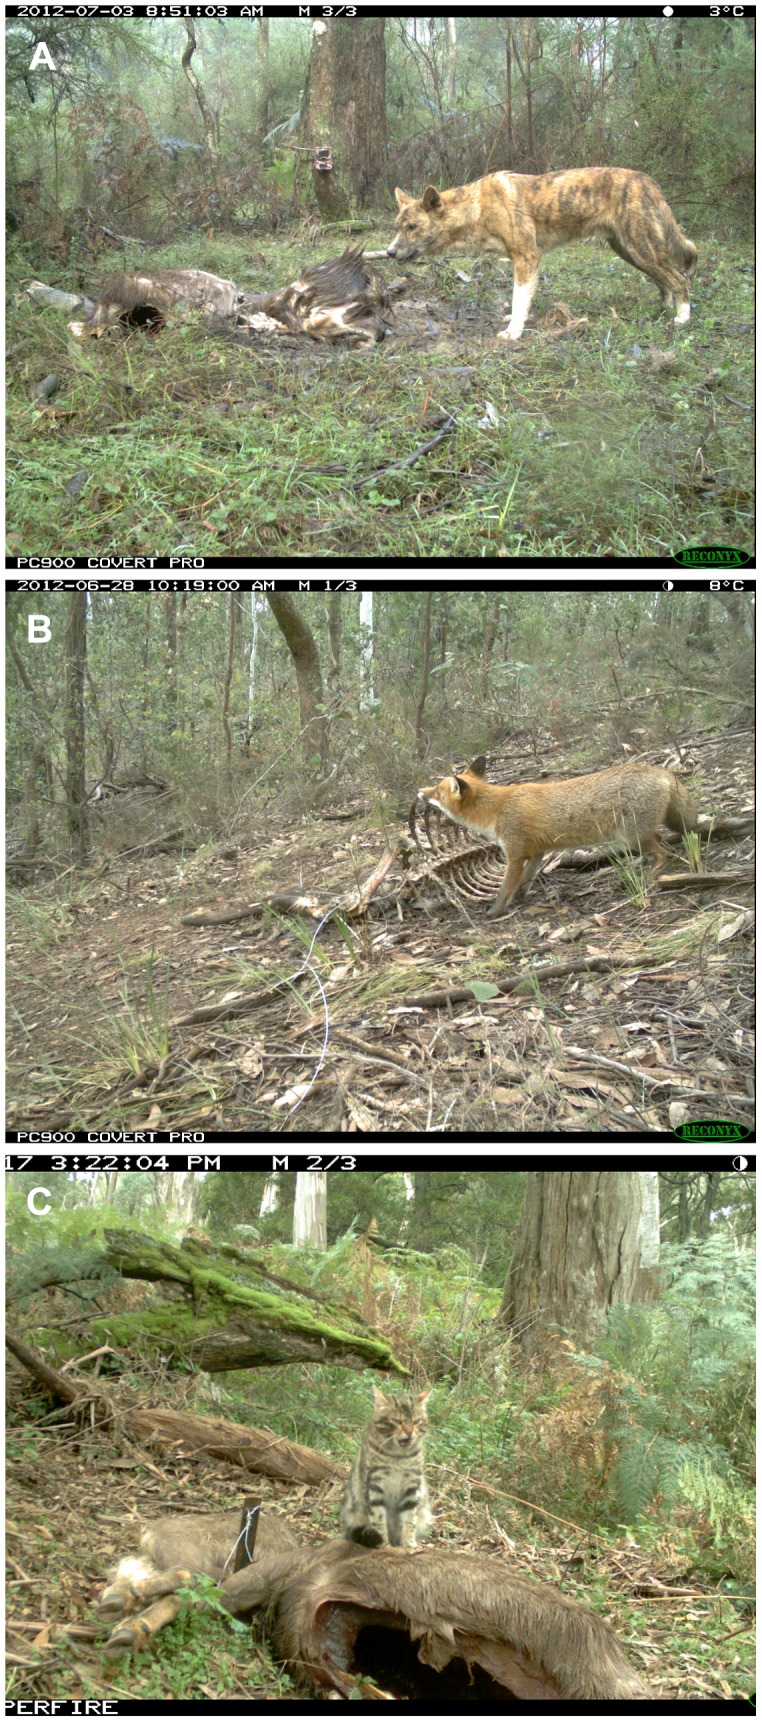
Carnivores feeding on sambar deer carcasses.(a) Wild dog; (b) fox; (c) feral cat. Note the second camera trap on the tree in the background of (a).